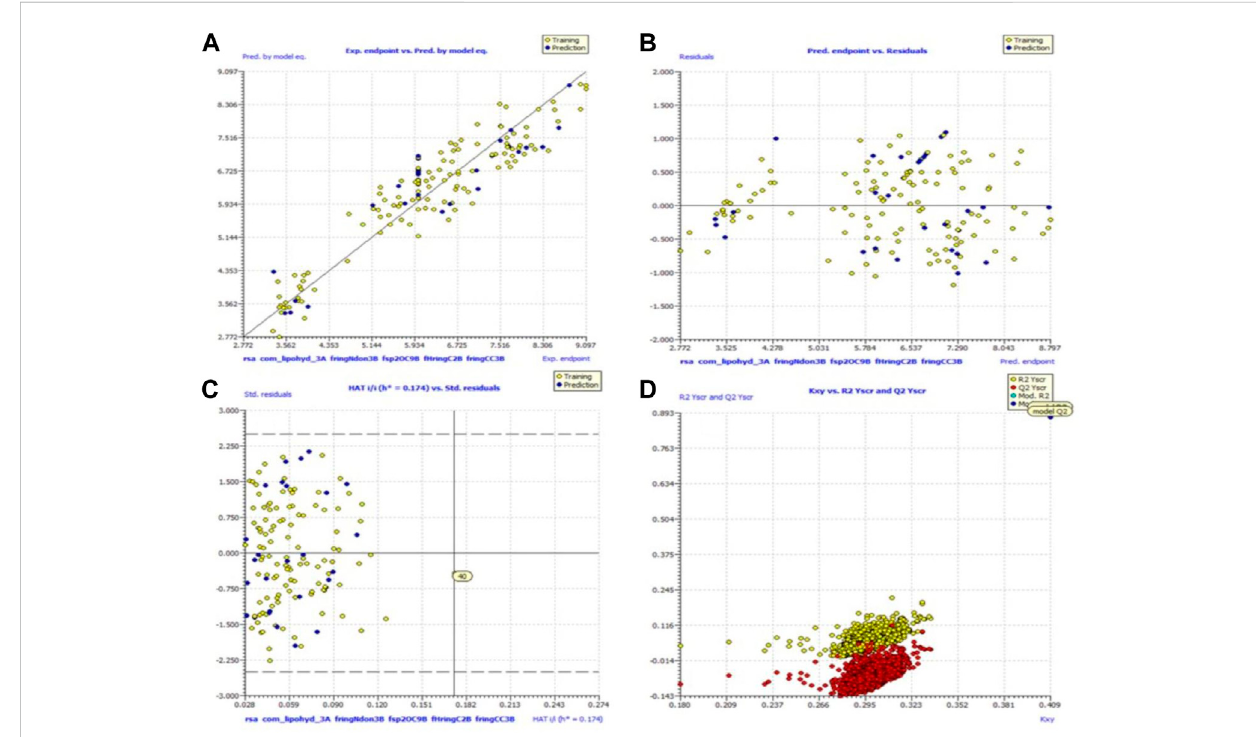
FIGURE 3 Different graphs related to model (A) experimental vs. predicted pKi (the solid line represents the regression line); (B) experimental vs. residuals; (C) William ’ s plot for applicability domain (the vertical solid line represents h* = 0.021 and horizontal dashed lines represent the upper and lower boundaries for applicability domain); (D) Y-randomization plot.